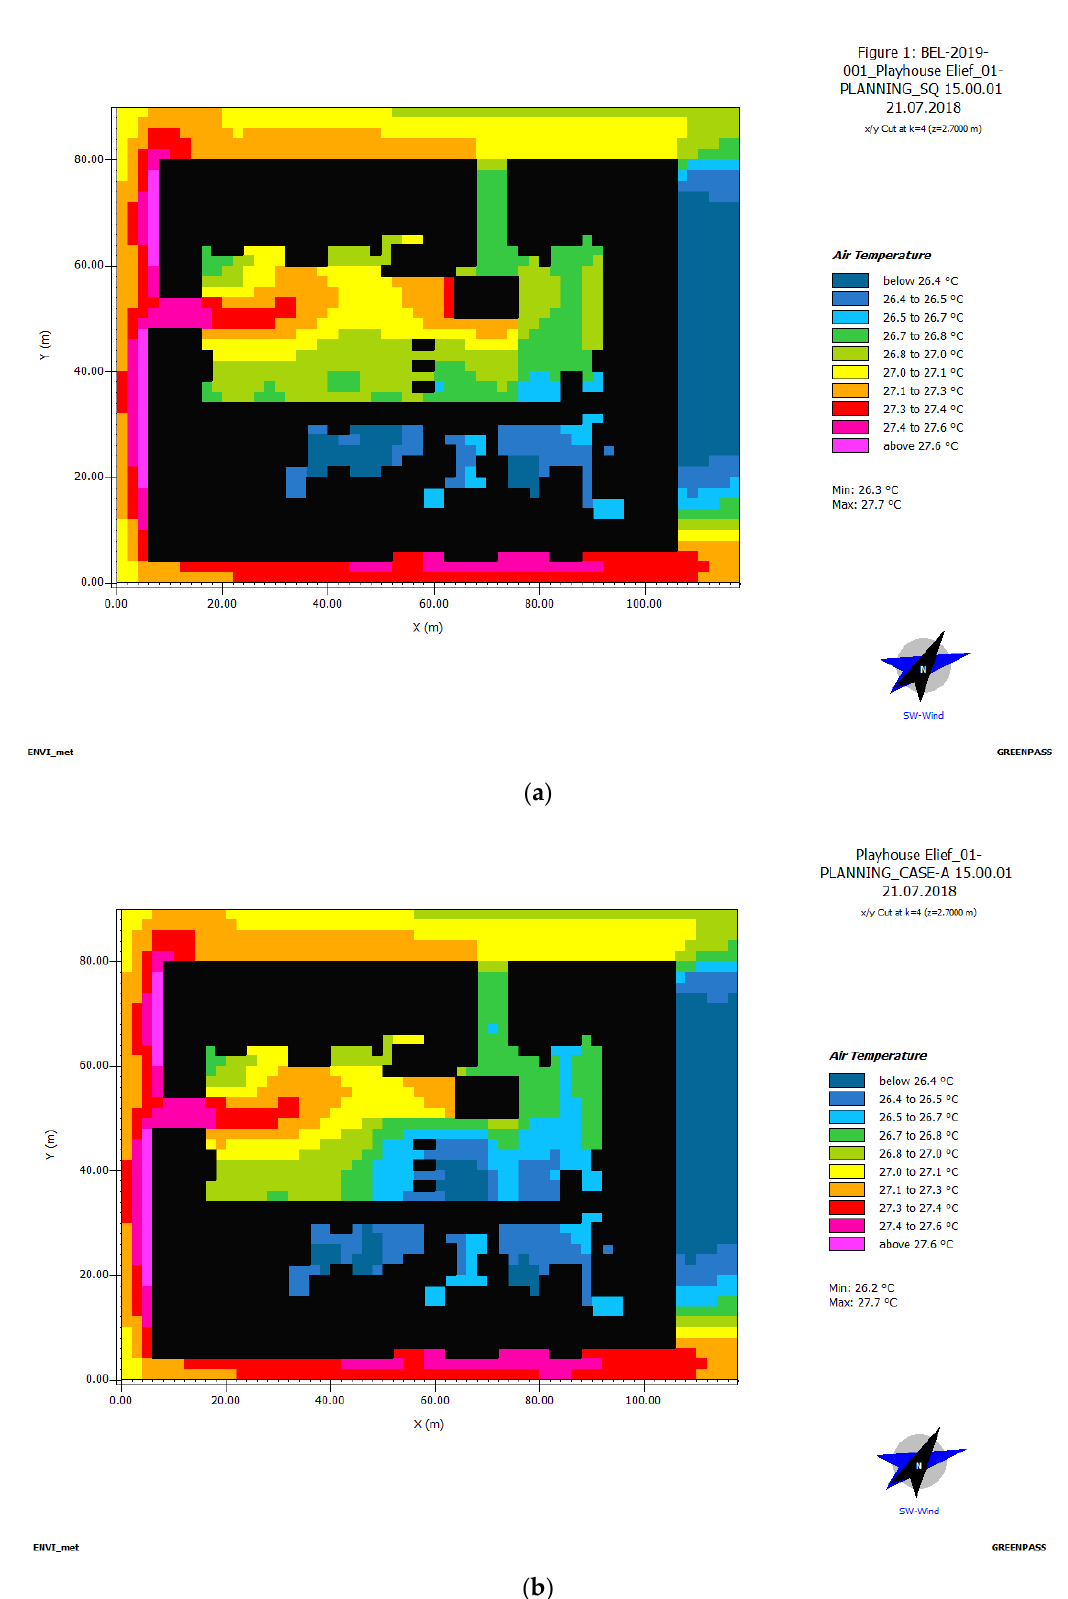
Figure 5. Results of microclimate simulation—Playhouse Elief Antwerp, comparison on a hot summer day 21.07. ( a ) Variant SQ—air temperature 15:00 at ground level; ( b ) Variant A—air temperature 15:00 at ground level; ( c ) Variant B—air temperature 15:00 at ground level .